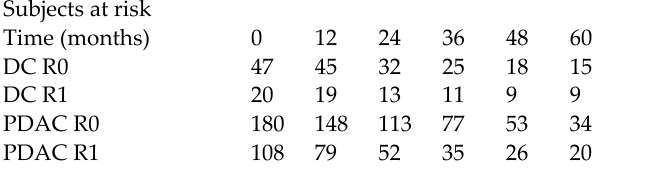
Figure 4. Overall survival among patients who underwent tumor resection according to margin status. ( a ) Distal cholan- giocarcinoma (DC); ( b ) Pancreatic ductal adenocarcinoma (PDAC).